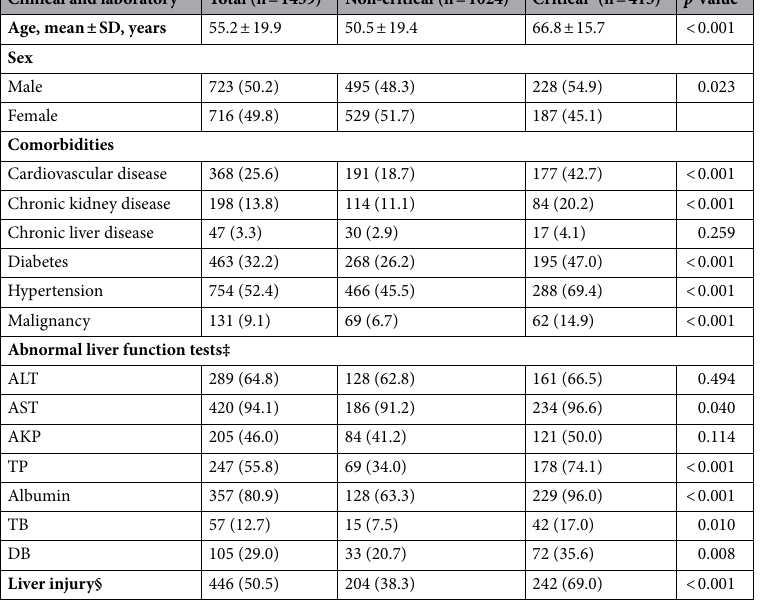
Table 1. Clinical characteristics of COVID-19 patients stratified into critical or non-critical groups. SD, standard deviation; ALT, alanine aminotransferase; AST, aspartate aminotransferase; ALP, alkaline phosphatase; TP, total protein; TB, total bilirubin; DB, direct bilirubin. † Patients were classified into critical and non-critical groups. Patients were defined as critical if they had any of the following outcomes: death, use of mechanical ventilation, or admission to the ICU. If they did not, they were defined as non-critical. ‡ The number and percentage for all the lab values are for patients with abnormal lab values (i.e., above the normal upper limit). § Liver injury was defined as any parameter above the normal upper limit (including ALT, 6–45 U/L; AST, 10–42 U/L; ALP, 34–104 U/L; TP, 6.0–8.0 G/DL; albumin, 3.5–5.0 G/DL; TB, 0.2–1.3 MG/DL; DB, 0–0.3 MG/DL), based on the worst liver function test result recorded during hospitalization.